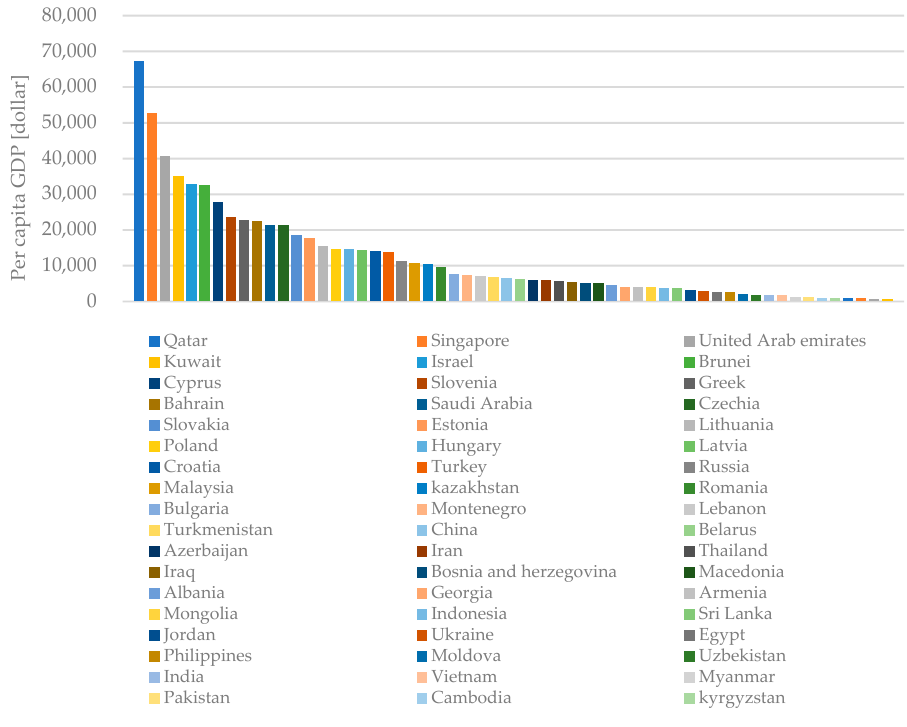
Figure 3. Per capita GDP of some countries in the BRI in 2015.